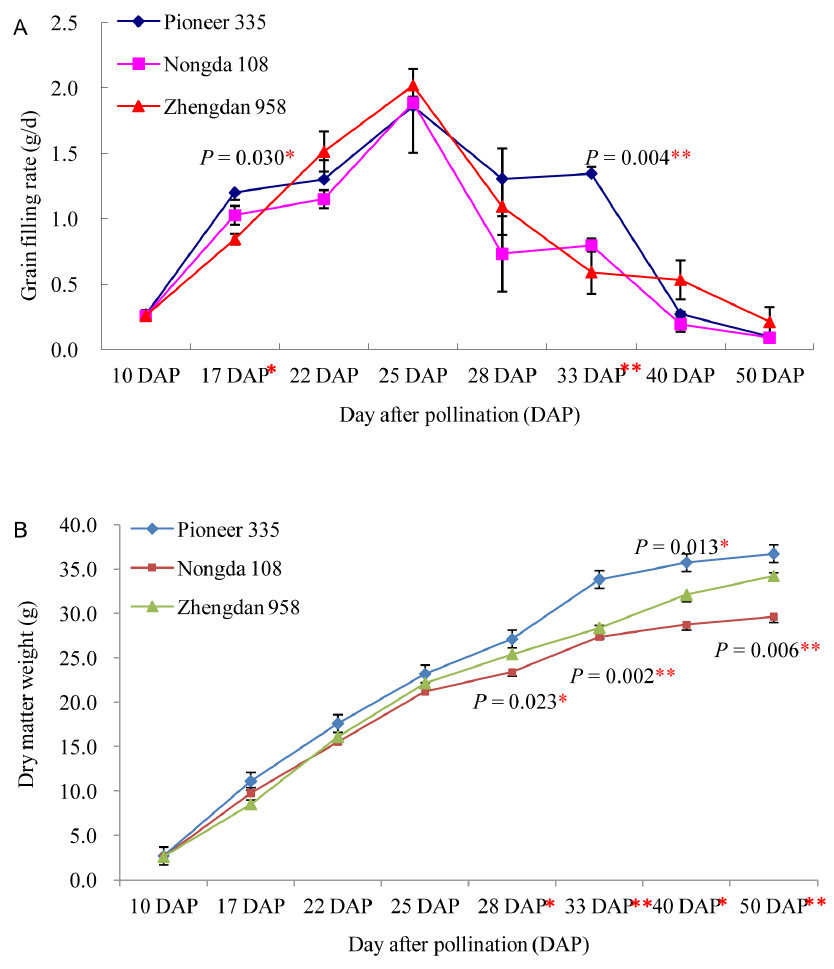
Figure 1. Grain-filling rate of the tested maize hybrids from 10 to 50 DAP.